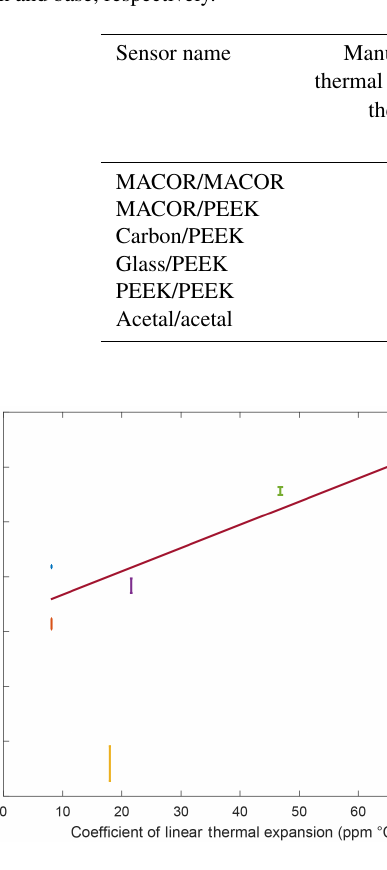
Table 3. Parameters of materials used in this study. The measured coefficient of thermal gain dependence for each sensor has been corrected by − 17ppm ◦ C − 1 to remove the measured correction applied by the electronics. The sensor name corresponds to the material in the sensor bobbin and base, respectively.